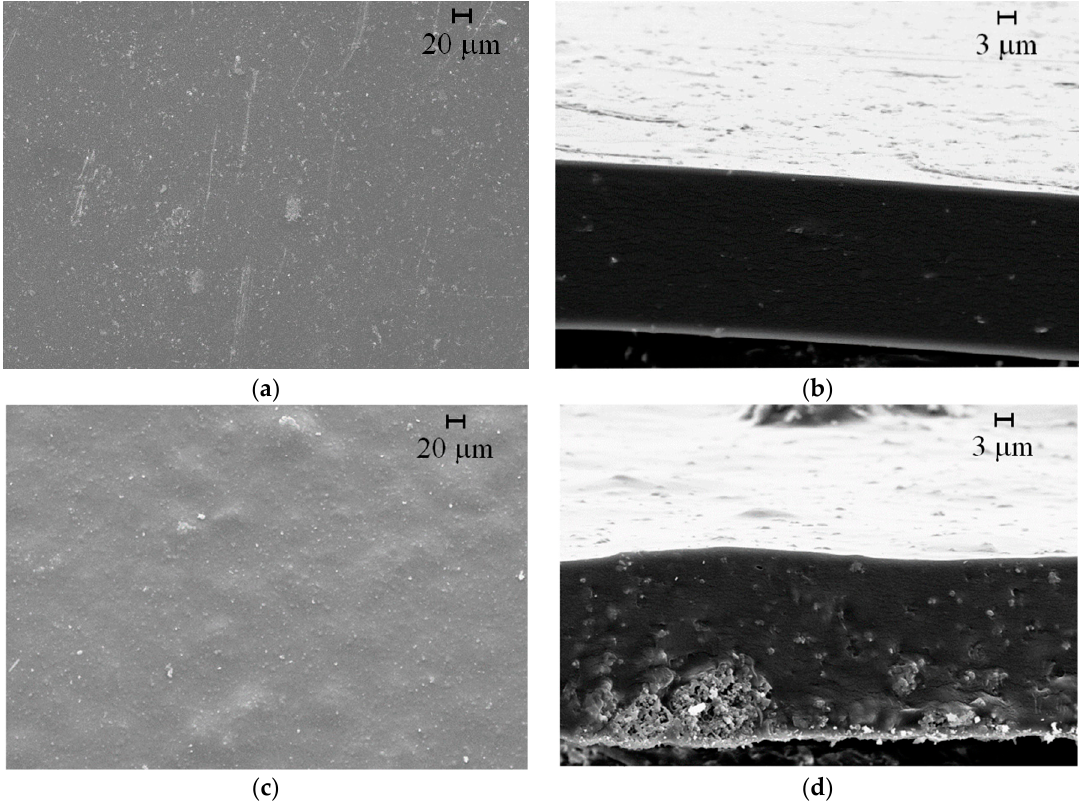
Figure 7. SEM micrographs of chitosan film (left: surface at magnification 500×); right: cross-section at magnification 3000×): AgSD/chitosan film ( a,b ); AgSD-Y/Chitosan film ( c,d ).